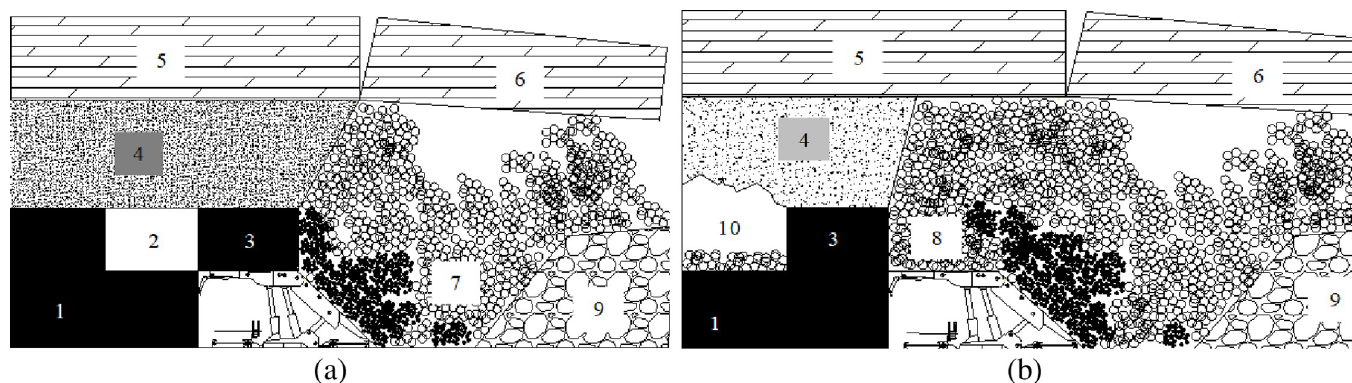
Fig 1. Re-mined face under (a) previous entries and (b) gob area in upper seam. 1. Lower seam;2. Previous entry; 3. Previous coal pillar; 4. Immediate roof; 5. Main roof; 6. Caved roof block; 7. Uncompacted gob materials from previous upper seam; 8. Caved materials sitting on the shield; 9. Compacted gob materials; 10. Previous unfilled gob in upper